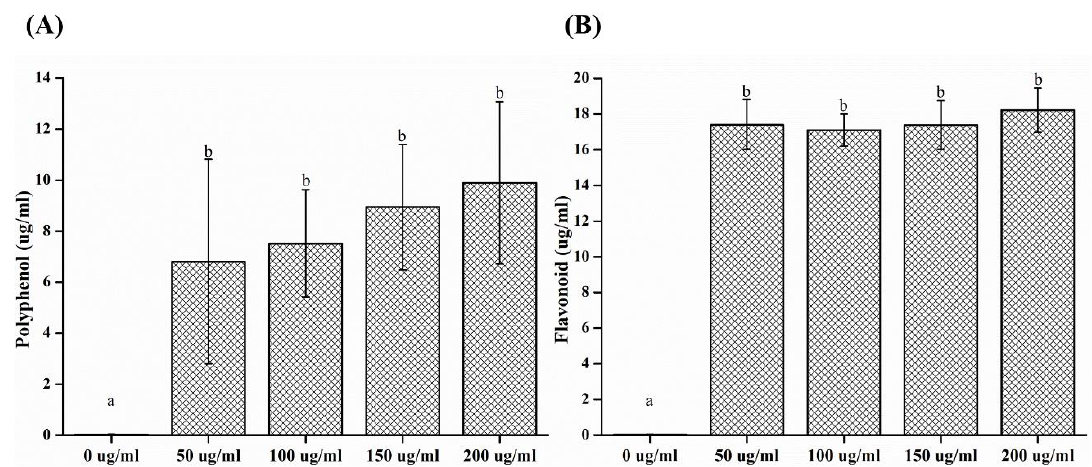
Figure 6. ( A ) Polyphenol and ( B ) flavonoid contents of CO extracts. Di ff erent letters above bars indicate significant di ff erences ( p <